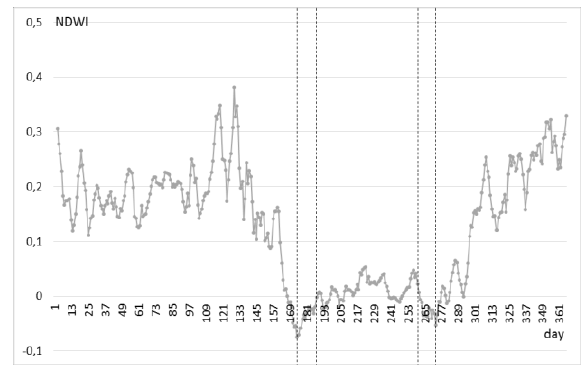
Figure 2. Annual NDWI graph of 2018 for the Petrun’ meteorological station; values are averaged using 5-day sliding window; time frames of growing seasons are marked by dashed vertical lines